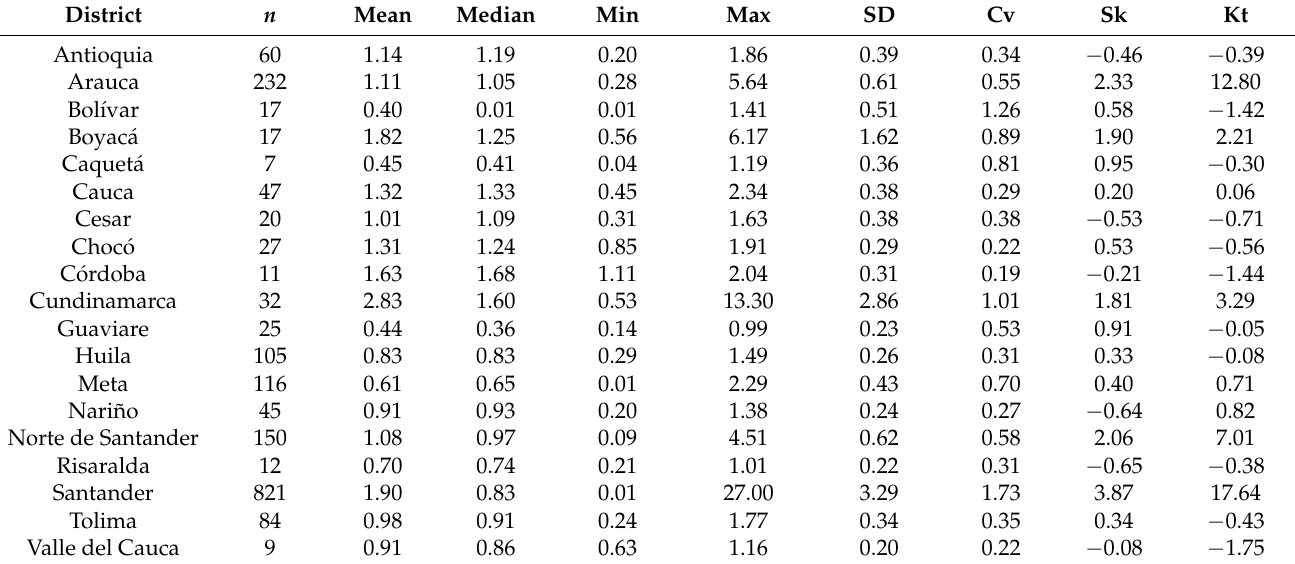
Table 1. Concentrations of Cd (mg kg − 1 ) in the soil assessed in cacao-growing districts of Colombia.